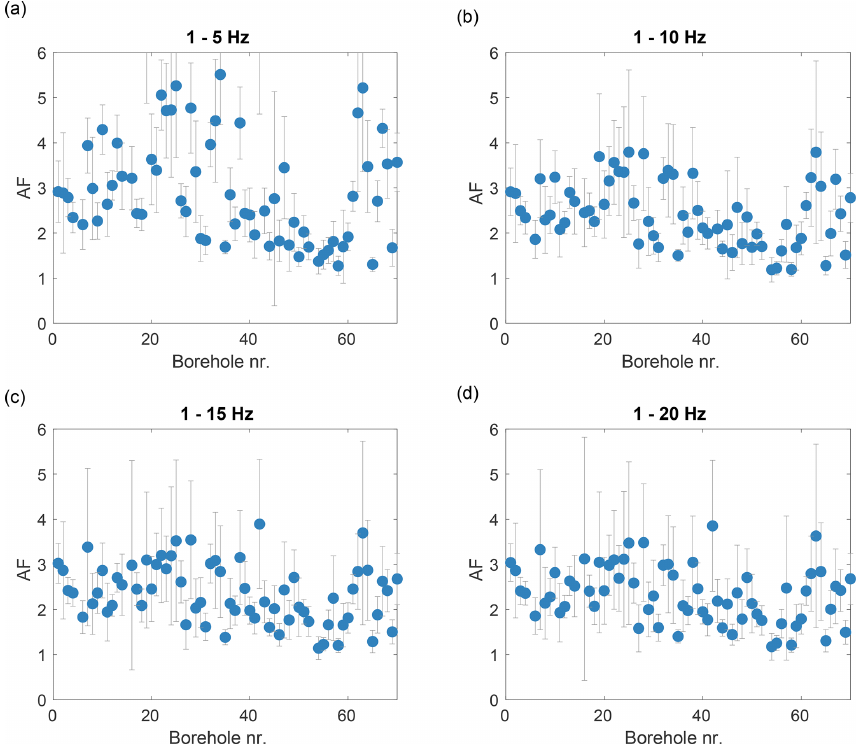
Figure 4. Amplification factors (AFs) for (a) frequency bands 1–5Hz, (b) 1–10Hz, (c) 1–15Hz, and (d) 1–20Hz and corresponding standard deviations (error bars) associated with the averaged AFs over 19 M ≥ 2 . 0 local earthquakes.